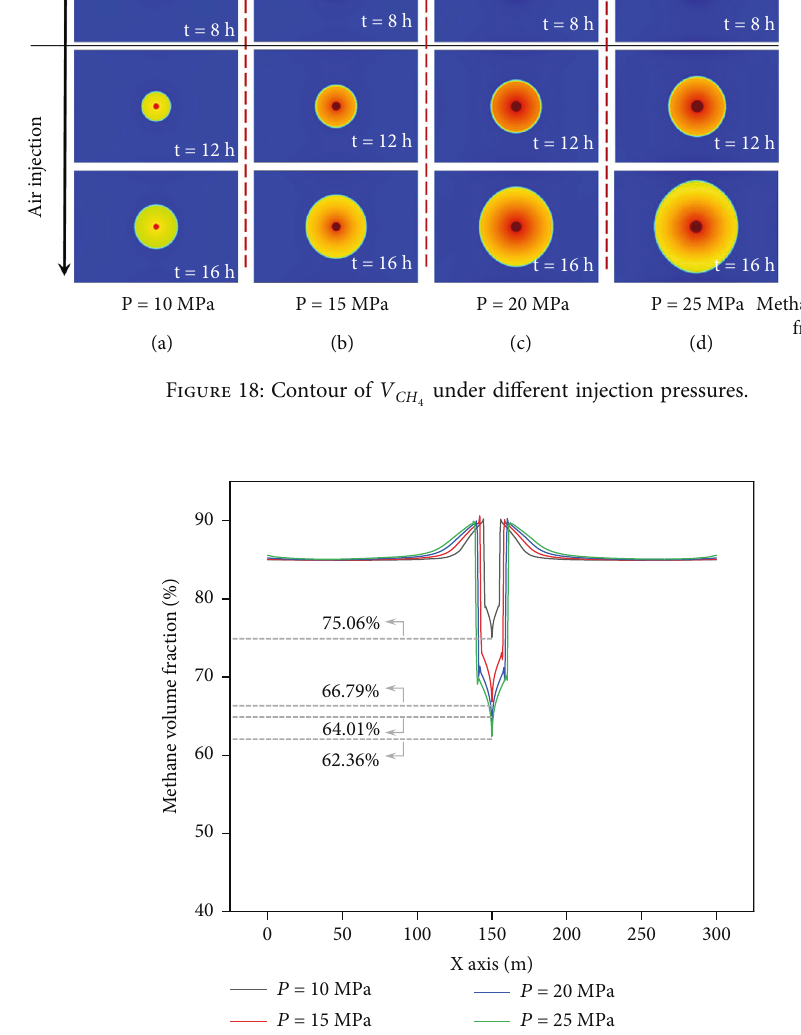
Figure 19: V at the end of water injection (8 h) along line CH 4